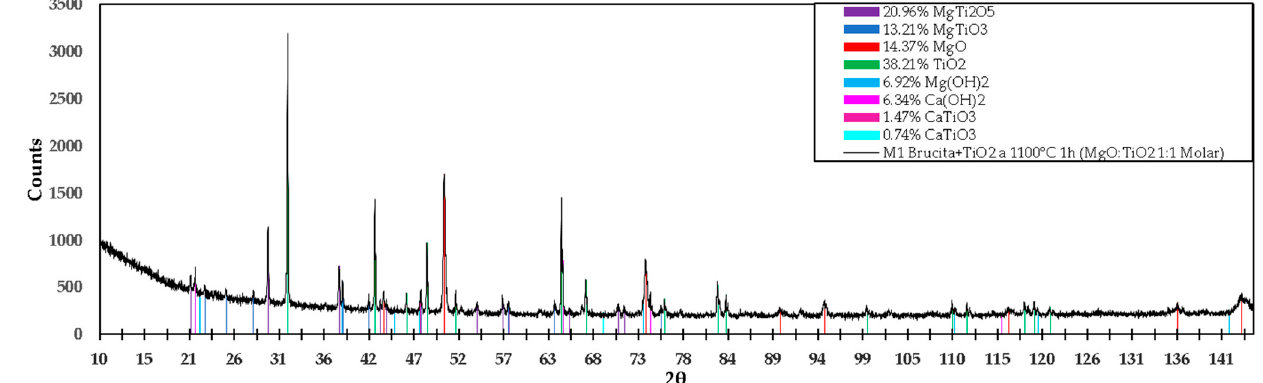
Figure 12. X-ray diffractogram of the formulation M1 (titania mixed with brucite and calcined at 1100 °C for 1 h).